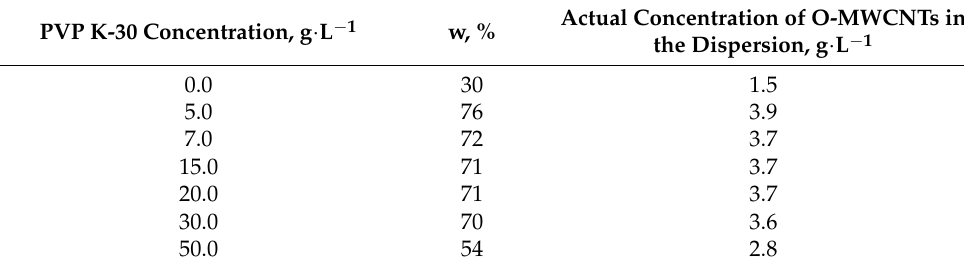
Table 3. O-MWCNTs dispersion degree (w) depending on the PVP K-30 concentration. PVP K-30 Concentration, g · L − 1 w, %